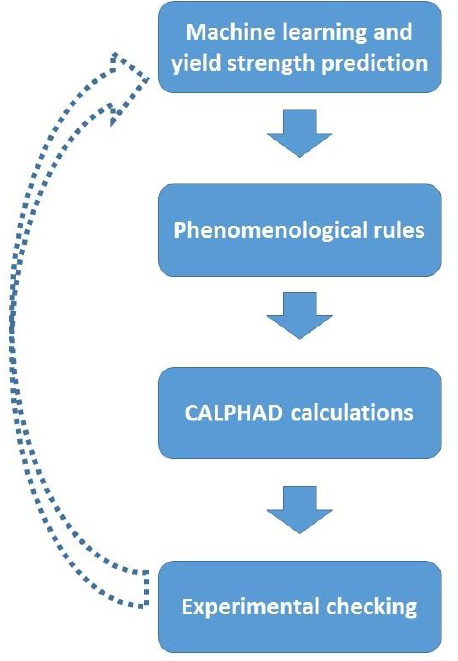
Figure 1. Schematic representation of the algorithm of model alloy selection.